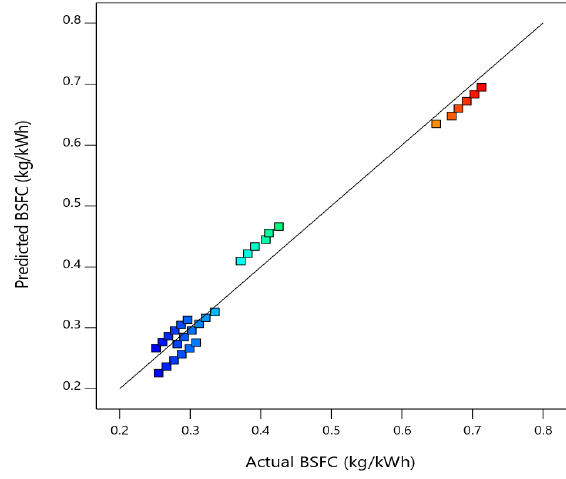
Figure 5. Comparison of actual and predicted BSFC. Table 7. ANOVA results for CO.